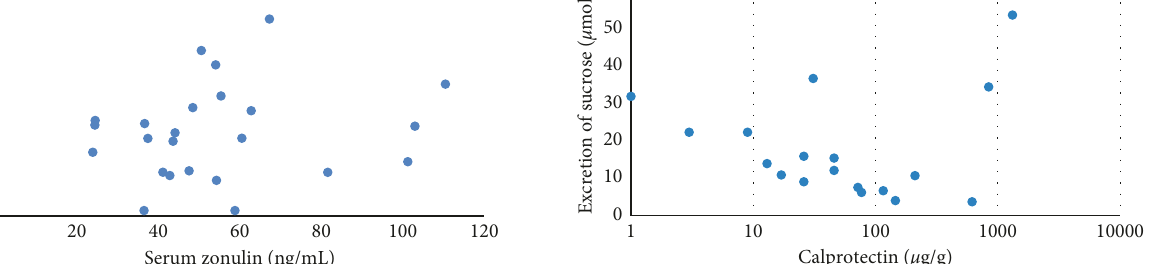
0 . 55 ,p 0 . 014) between the 0–5 hour (cid:31) (cid:31) 18 paired samples). (cid:31)